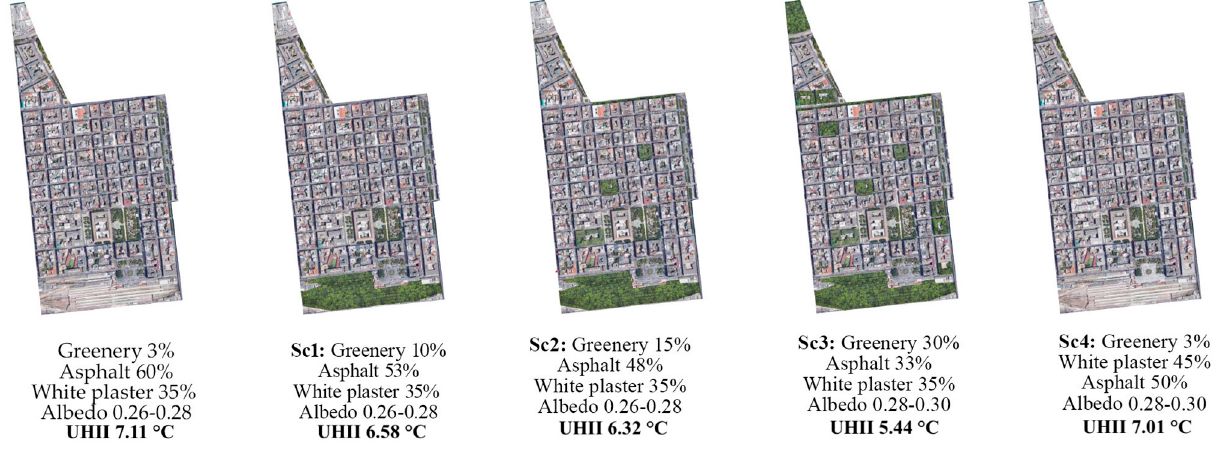
Figure 7. The proposed scenarios in the central district of “Murattiano”, Bari with increase in greenery and white plaster.